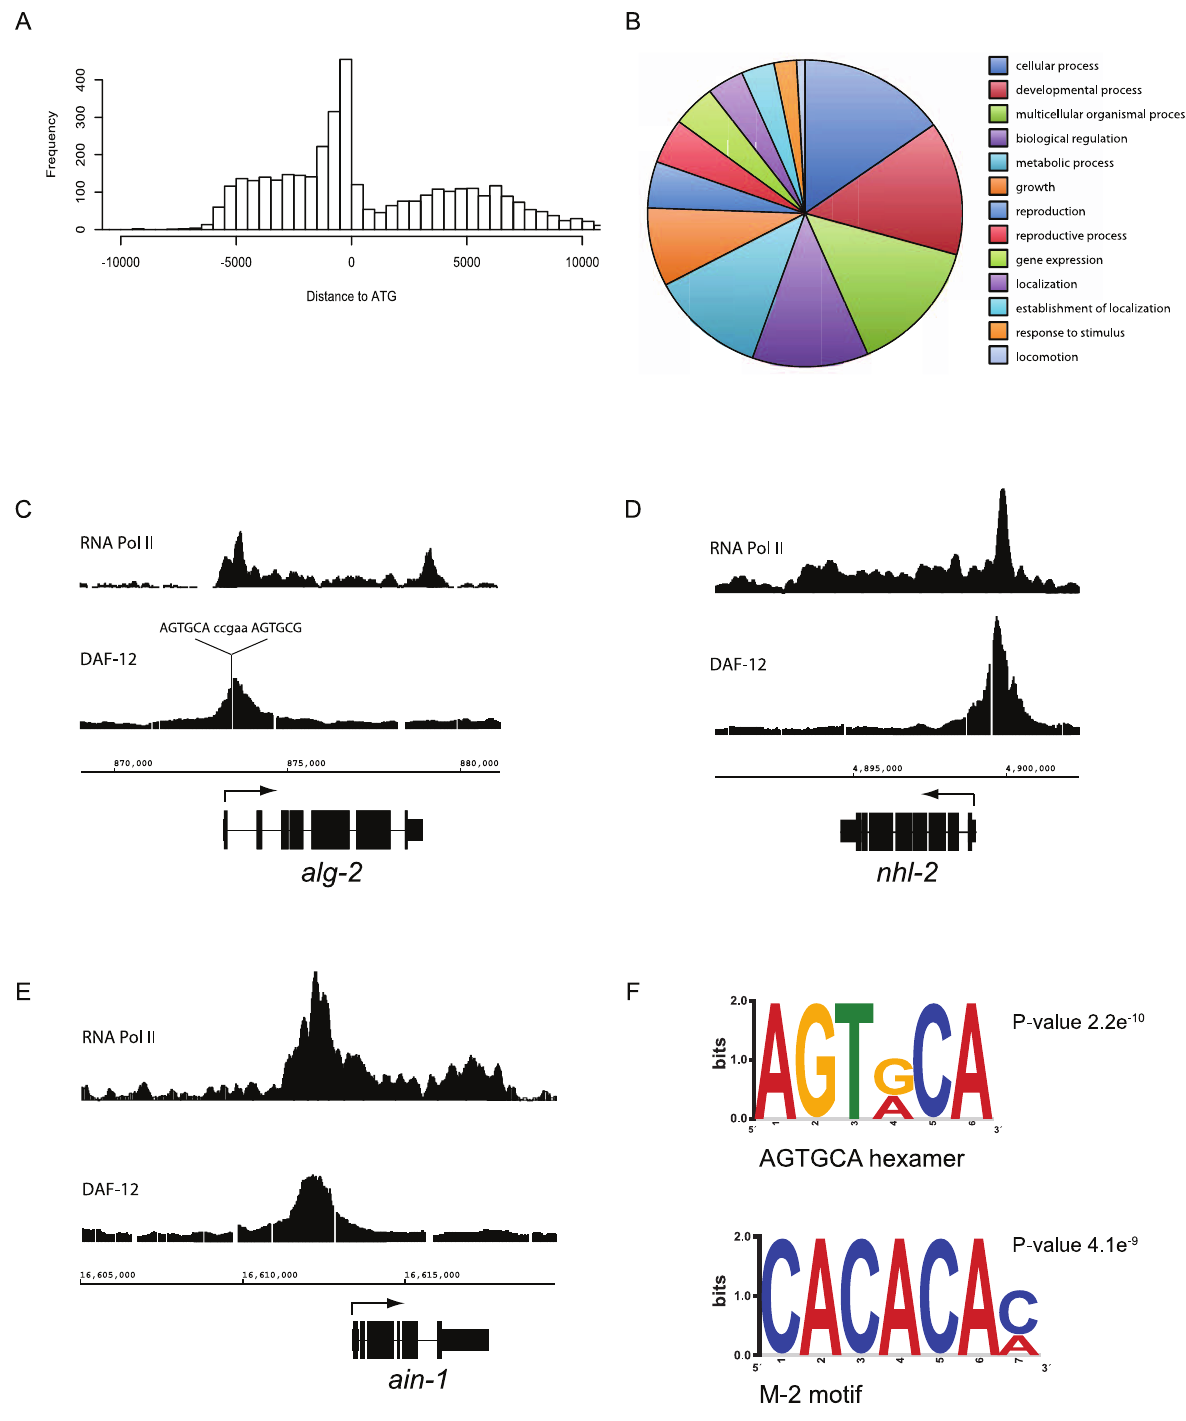
Figure 2. Analysis of DAF-12 binding sites. ( A ) Distribution of the distance between DAF-12 binding sites and candidate gene targets (ATG). ( B ) Pie chart illustrates gene ontology for candidate target genes defined by biological function. ( C ) RNA pol II and DAF-12 binding sites in L2 stage animals were compared within the miRISC gene alg-2 using IGB software. A DR5 sequence within the DAF-12 binding peak is shown. ( D ) Analysis of the miRISC gene nhl-2 . A total of 15 AGTGCA-related hexameric sequences were found. ( E ) Analysis of the miRISC gene ain-1 . Multiple M-2 motifs were found. ( F ) AGTGCA-related sequences and M-2 motifs were over-represented among DAF-12 binding regions as identified by the MEME and DREME programs. The statistical significance of the motifs determined by p-values is also shown.